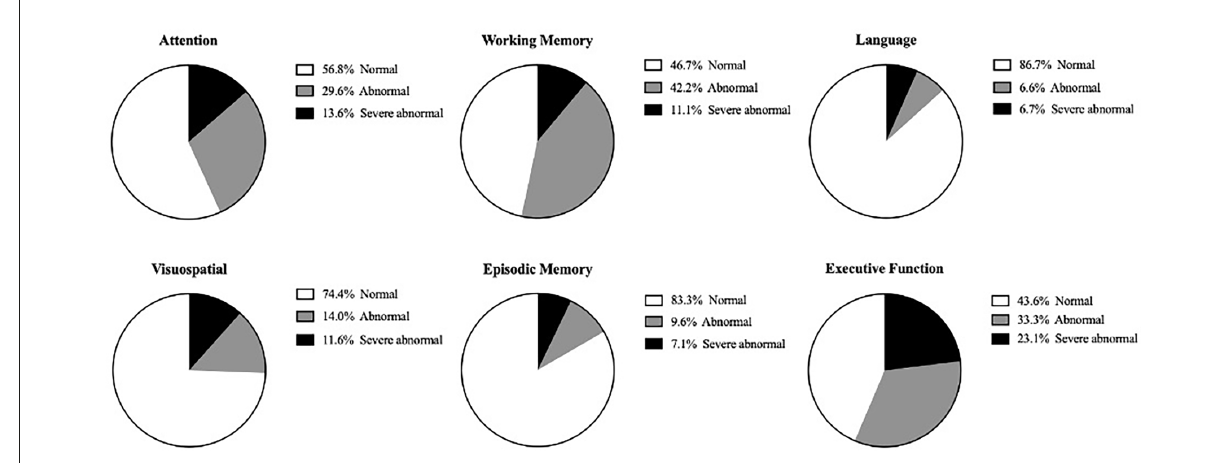
FIGURE1 The percentage of impaired cognitive patients in each cognitive domain.